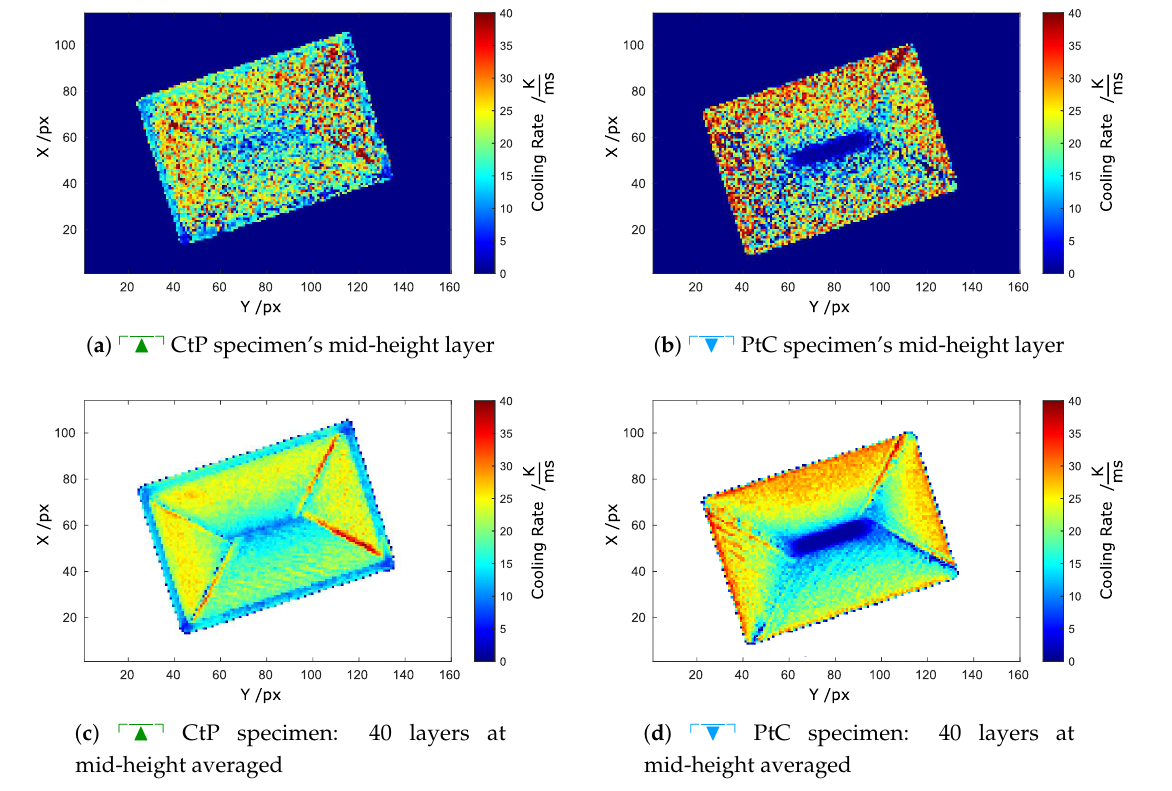
Figure 4. Cooling rates measured by the different between images taken at t = 1ms and t = 2ms after an apparent temperature of 700K was observed for the last time. Thermography data for both samples was obtained during the build process at the middle of the total build height. ( a , b ) display the mid-height layer, ( c , d ) display an average of 40 layers around the middle of the total build